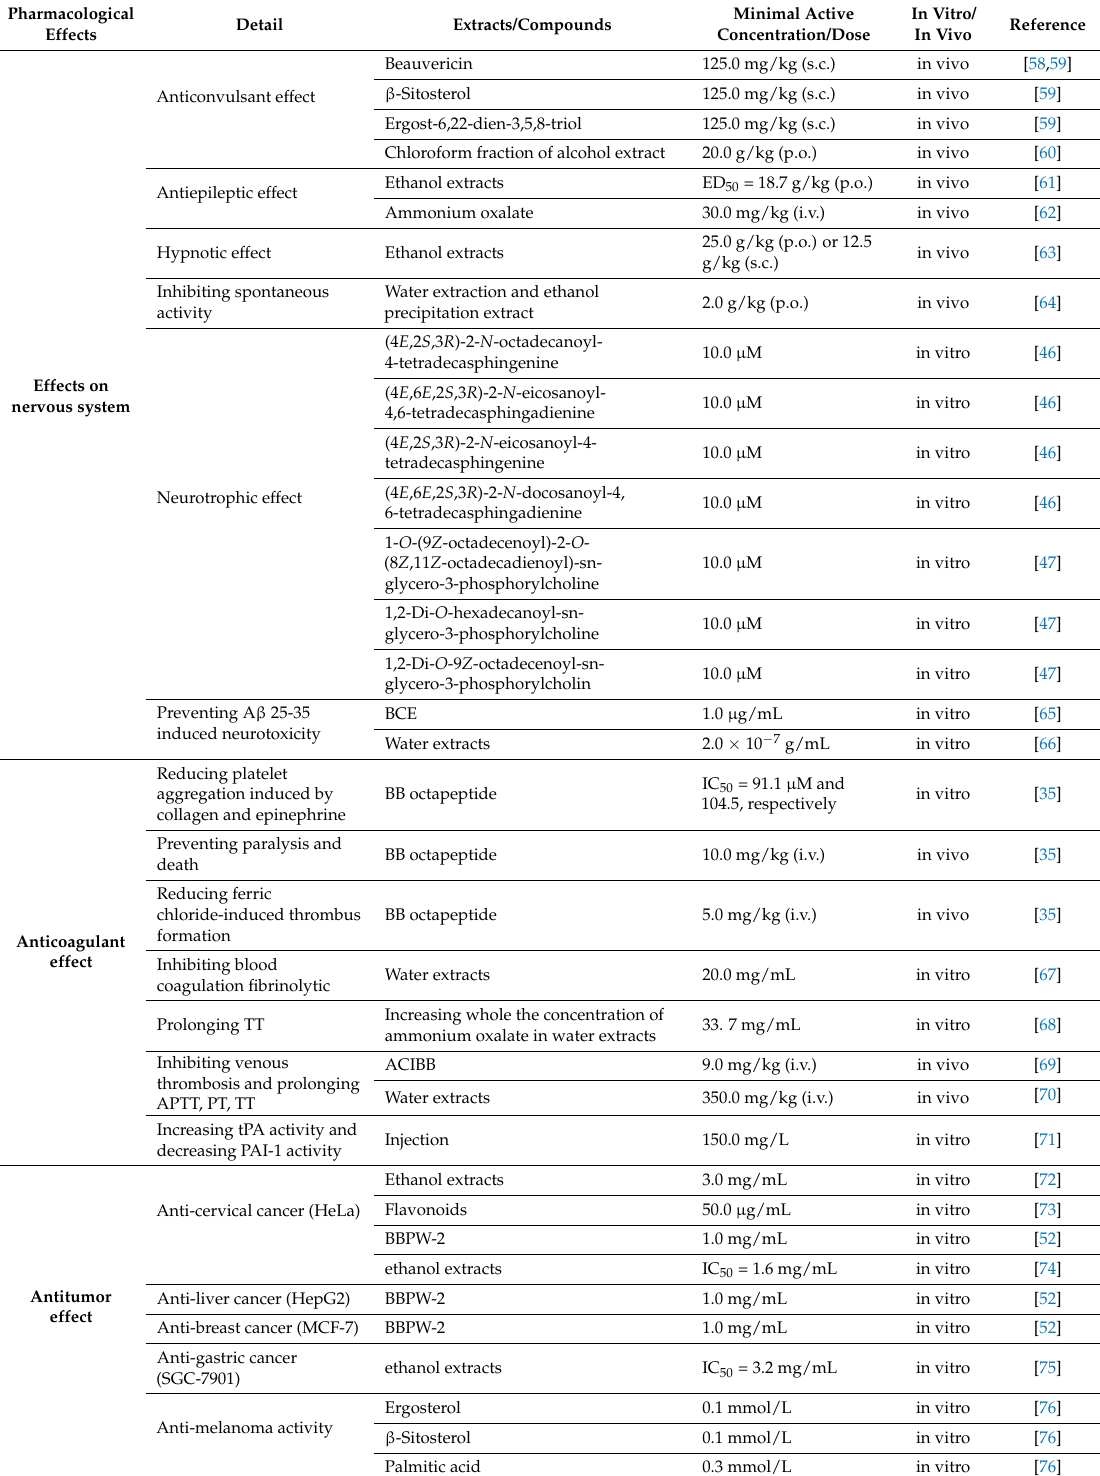
Table 3. Pharmacological effects of B. batryticatus